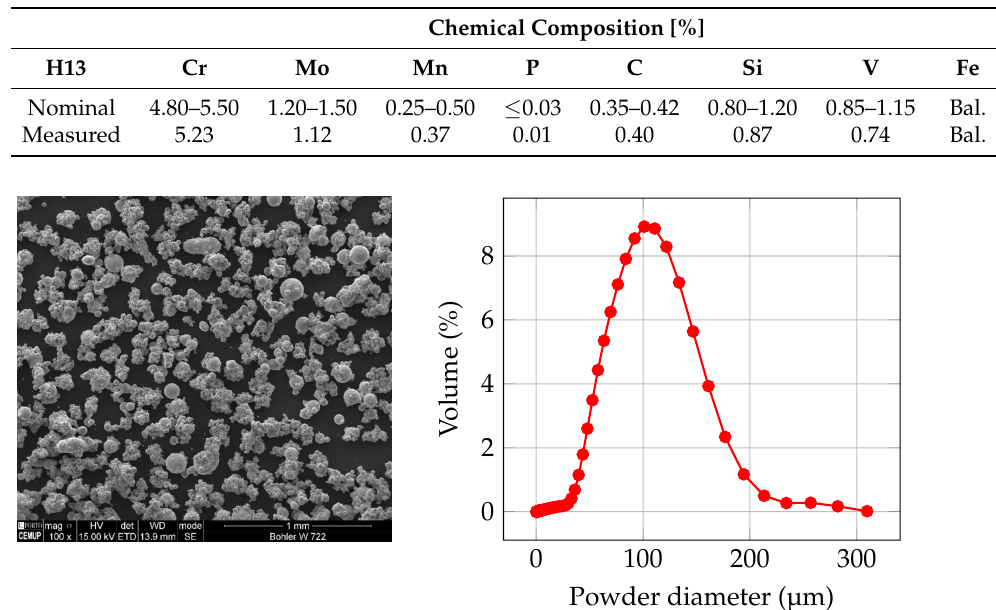
Table 1. Chemicals composition of the substrate, an AISI H13 tool steel alloy.